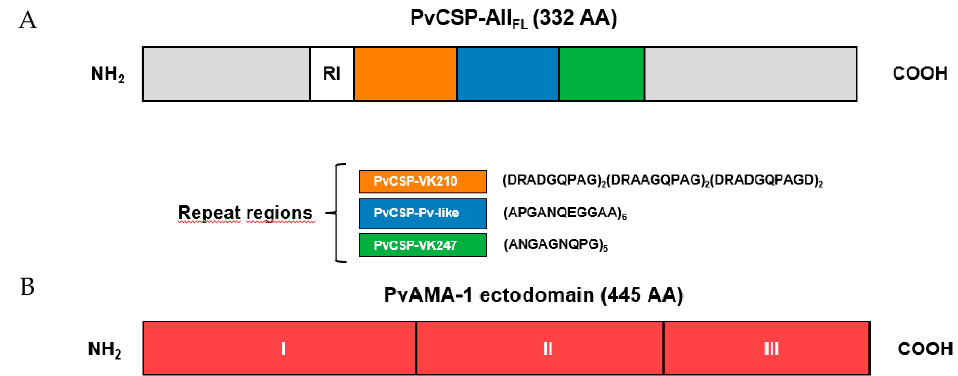
Figure 1. Representation of Plasmodium vivax proteins expressed in Pichia pastoris . Schematic representation of the PvCSP-All FL construction. Sequences from variant repeats in the central region are indicated ( A ). Schematic representation of PvAMA-1 ectodomain and its subdomains (DI, DII, and DIII) ( B ).